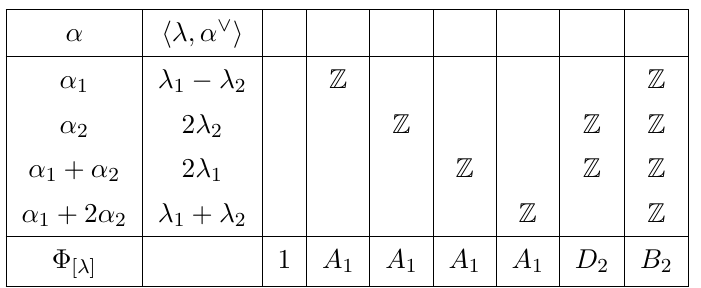
Table 1 . The positive roots (cid:11) of the B 2 algebra, the scalar product of the roots with the weights (cid:21) = (cid:21) 1 e 1 + (cid:21) 2 e 2 as well as the root systems (cid:8)